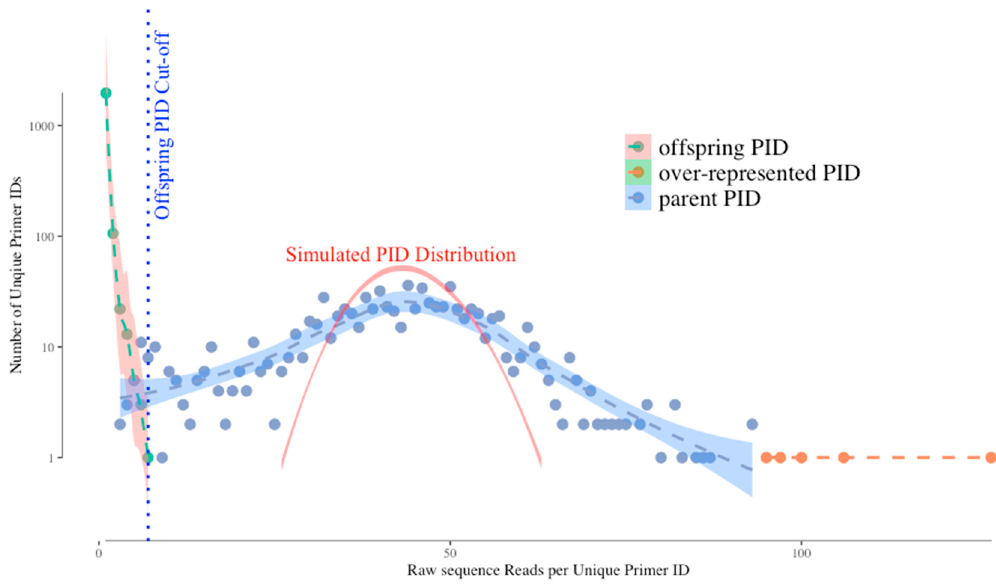
Figure 1. A Typical unique molecular identifier (UMI) (Primer ID) Frequency Distribution. The raw sequence output from a MiSeq run was sorted for individual UMIs and the number of reads for each UMI (after PCR) is plotted versus the number of UMIs with that read number. There is a large number of UMIs with very small read numbers (green dots to the left of the curve) representing offspring Primer IDs, i.e., Primer IDs generated from real Primer IDs by sequencing mistakes. The middle part of the graph shows the distribution of real Primer IDs (blue dots) and the fact that they are present in unequal numbers in the PCR product. This is not solely due to sampling of an otherwise equal distribution in the PCR product as a simulation of the same amount of the Primer IDs in this dataset (851) sampled 37,177 times (equal to the number of total raw reads in this dataset) to give the same mean read number as the observed distribution shows a much narrower spread (plotted as a red line in the figure). Finally, there are a small number of “jackpot” Primer IDs to the right (orange dots) that represent extreme PCR skewing and/or resampling of the Primer ID/UMI population. The blue dotted vertical line shows the offspring cut-off based on a simulation.